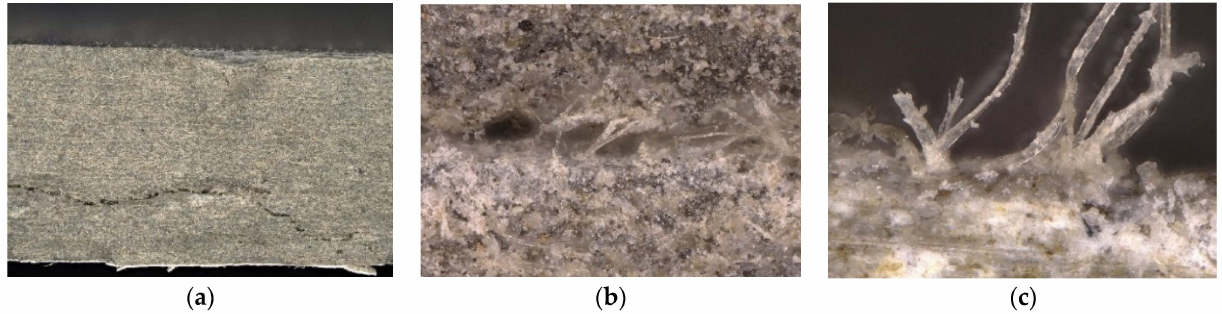
Figure 11. View of the reference sample under a digital microscope: ( a ) magnification × 20, ( b ) mag- nification × 150, ( c ) magnification × 400.